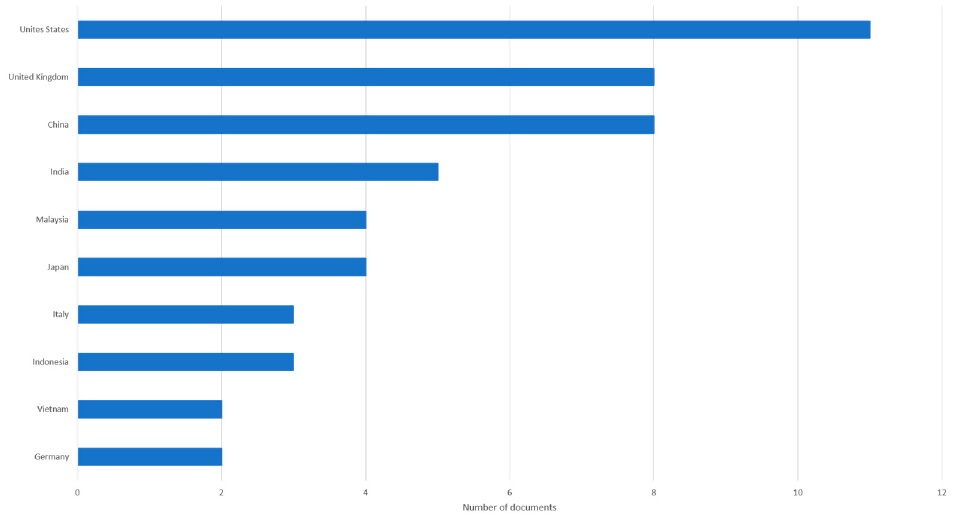
Figure 5. Documents by country or territory for bioplastics or bio-plastic or acrylic acid (Appendix